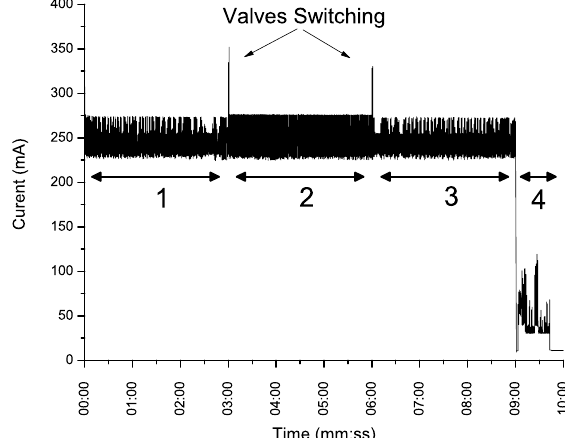
Figure 9. Current analysis of the landfill system during a full monitoring routine (1) baseline procedure, (2) sampling procedure, (3) purge procedure, (4) communications and storage